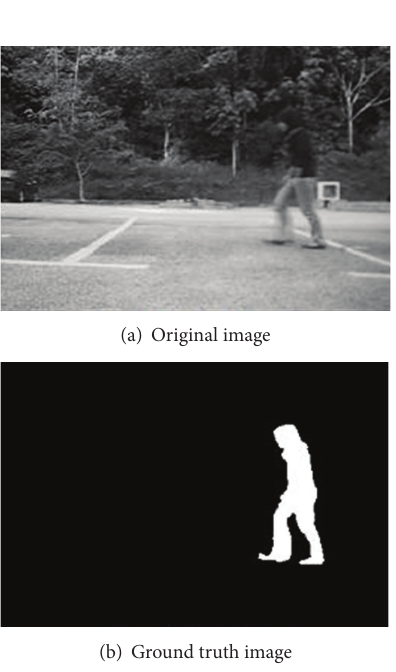
Figure 2: Background image of data in this study.